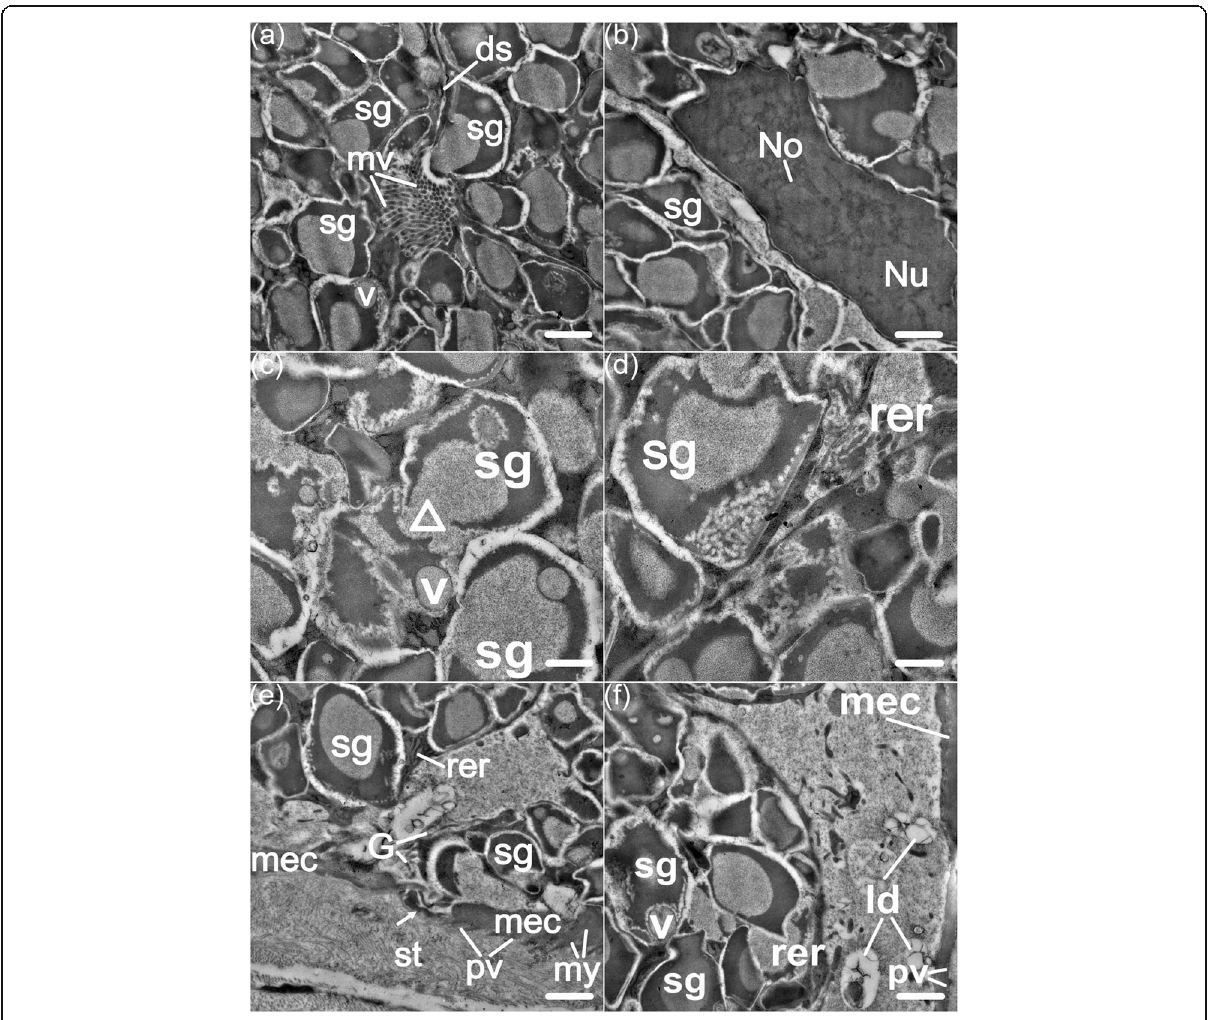
Fig. 4 Transmission electron micrographs of SMGs in the postaxillary glands of male N. pleuraden . a Longitudinal section of SMGs, note the microvilli and the desmosome connecting two contiguous mucocytes. b A euchromatic nucleus surrounded by numerous secretory granules. c Translucent vesicles are released from large secretory granules via a breach on granular border. d Secretory granules hold materials of varying electron-density, note the dilated rough endoplasmic reticulum at the supranuclear region. e The discontinuous myoepithelial sheath across the secretory unit and glandular stroma, note the plasmalemmal projection of the mucocytes (arrow). f supranuclear cytoplasm of the mucocyte contains lipid droplets in low electron-opaque. sg, secretory granule; mv, microvilli; ds, desmosome; rer, rough endoplasmic reticulum; v, vesicle; No, nucleolus; Nu, nucleus; △ , breach of the secretory granule; G, Golgi stack; mec, myoepithelial cell; my, myofilament; st, stroma; pv, pinocytotic vesicle; ld, lipid droplet. Bars = 1 μ m ( a , b , e , f ) and 0.5 μ m ( c , d